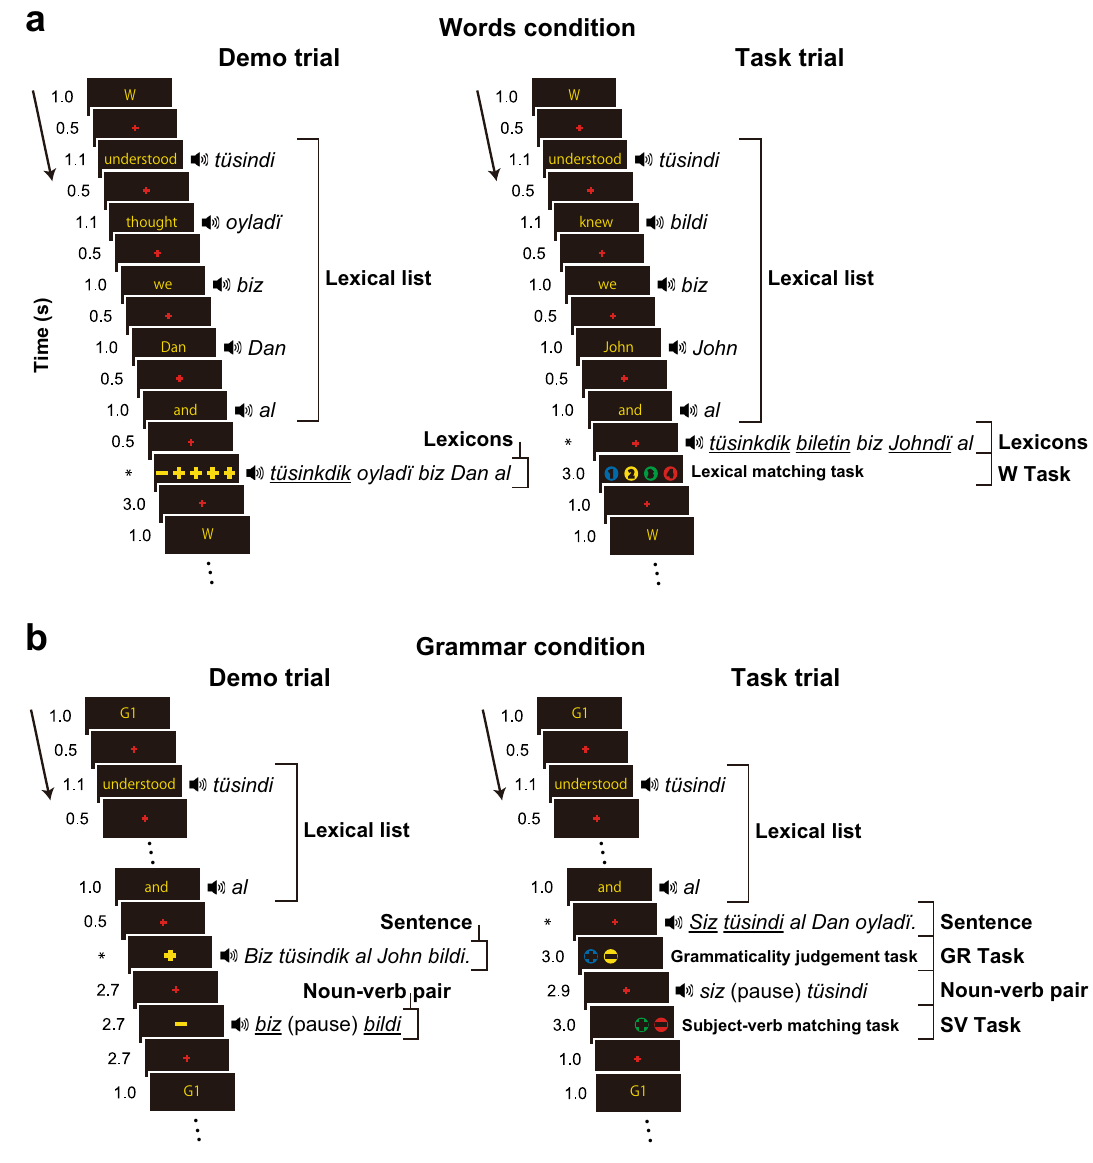
Figure 1. Words and Grammar conditions in Kazakh. ( a ) A trial under the Words (W) condition. A set of five Kazakh words (Lexicons) followed the Lexical list, replacing some words in the Lexical list with ones having an inflectional change, but in the same order (underlined words denote mismatch). In the demo trials, the +/− signs indicated correctness of simultaneously presented stimuli, while in the task trials, the participants chose a number (or a sign under the Grammar conditions) for the stimuli presented immediately before. Asterisks denote the variable duration of an auditory presentation. ( b ) A trial under the Grammar condition of G1. A Kazakh sentence (Sentence; underlined words denote ungrammaticality) followed the Lexical list, after which a noun–verb pair was presented (underlined words denote mismatch). The example sentence in Kazakh shown in the demo trial means “ We understood and John knew ,” while that in the task trial is ungrammatical. For the task trials, there was a silent pause of 0.5 s between the Lexical list and Sentence/Lexicons. In activation analyses, we focused on the temporal events of the Sentence, Lexicons, and Lexical list in the task trials. These images were created using Adobe Illustrator (ver. 16.0.3, https:// www. adobe. com/ produ cts/ illus trator.